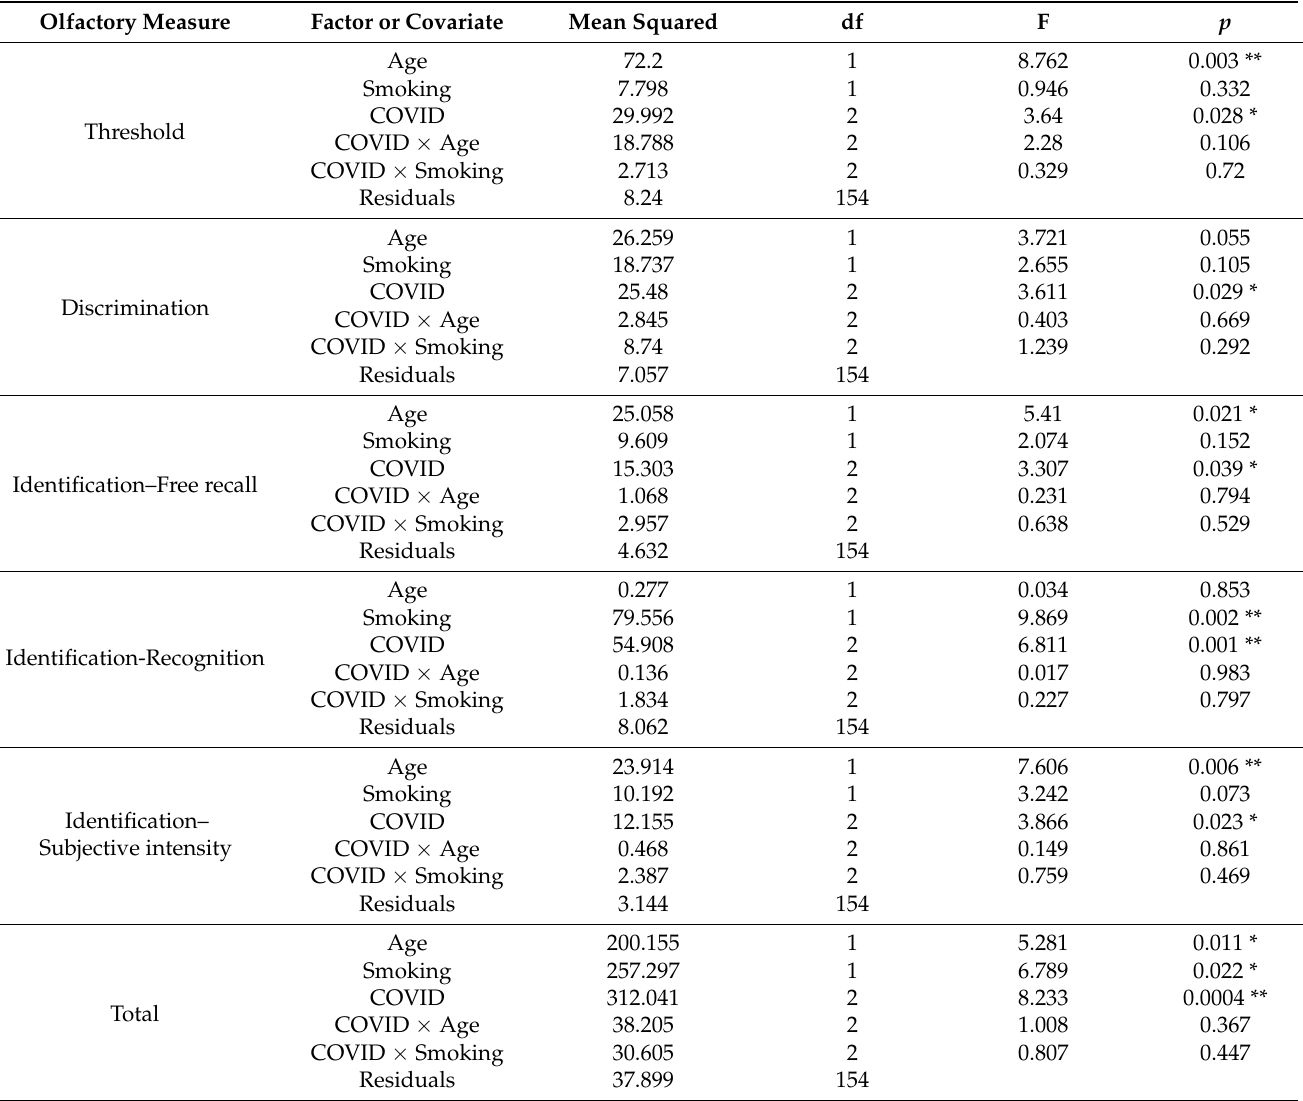
Table 3. One-way Analysis of Covariance (ANCOVA) for each olfactory